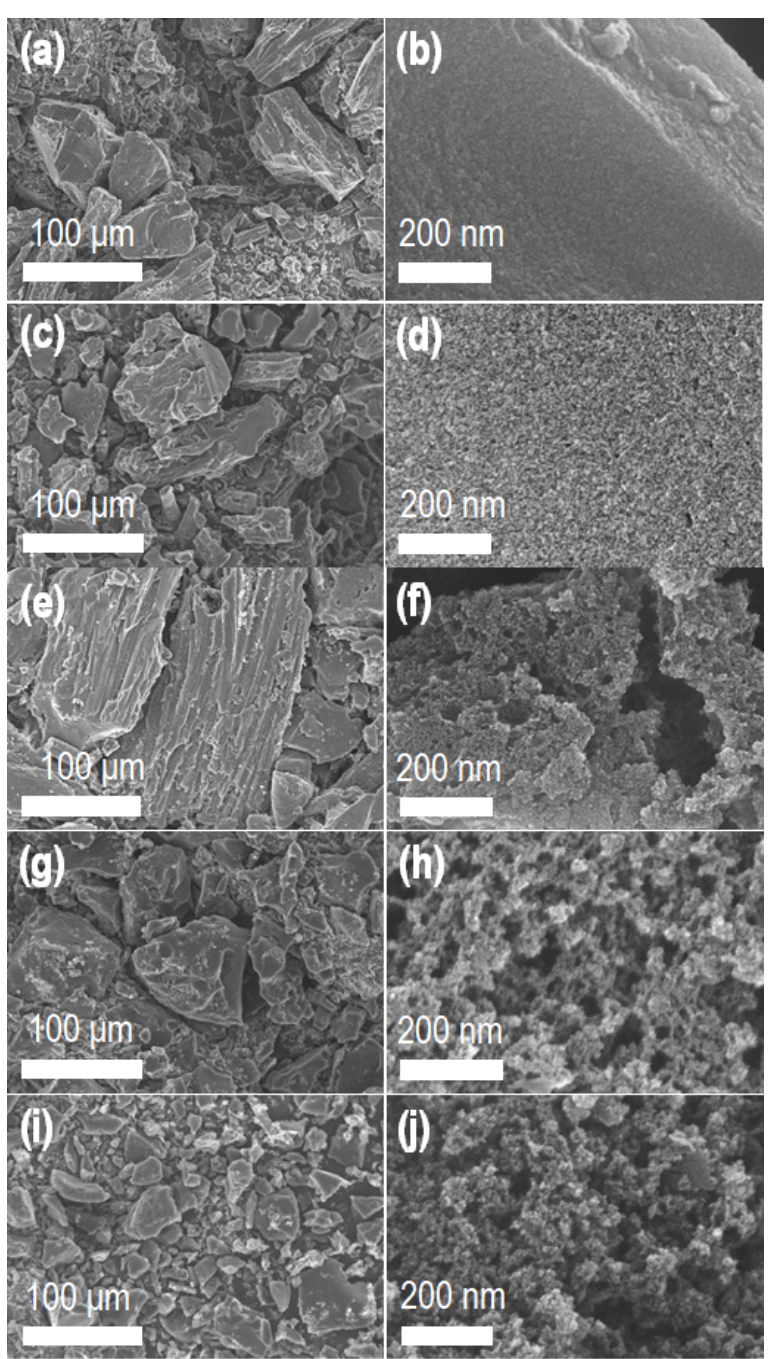
Figure 2. Scanning electron microscope (SEM) images of nanoporous carbon materials. ( a–b ) LSC_0 , ( c–d ) LSC_0.5 , ( e–f ) LSC_1 , ( g–h ) LSC_2 and ( i–j ) LSC_4 .